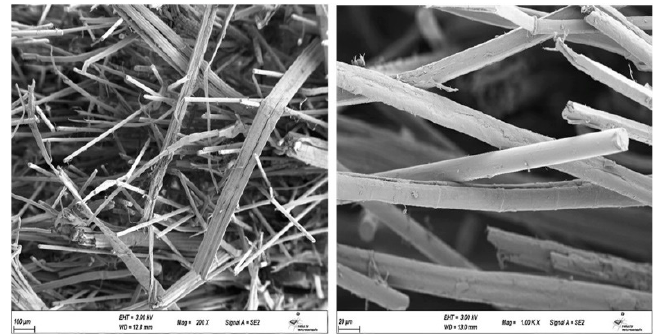
Figure 11. SEM analysis of PP/25GF/KEFL composite.